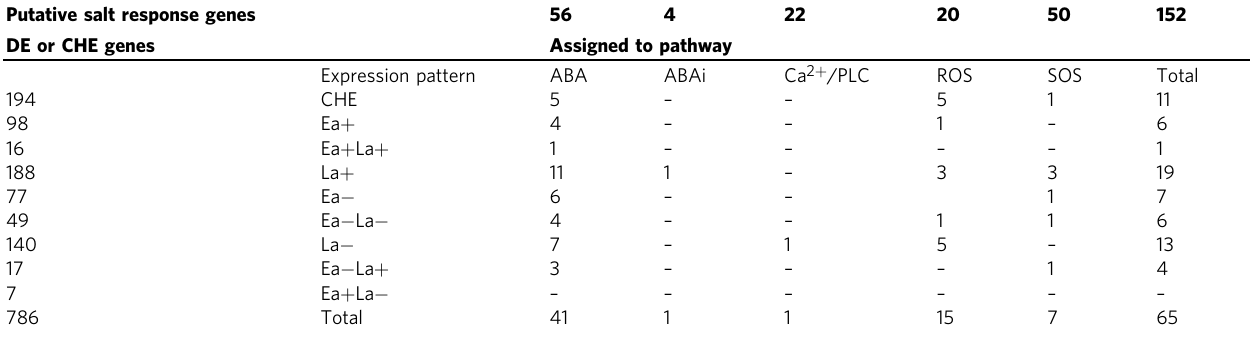
The fi rst column is devoted to the distribution of the eight genes classes with a signi fi cant pattern. In the second column, “ Ea ” refers to increased ( + ) or decreased ( − ) expression at 4h, “ La ” to variations of expression at 6 or 10 days. “ CHE ” stands for “ constitutively highly expressed. The fi rst row is devoted to the distribution of the 152 homologs of rice or Arabidopsis genes involved in salt resistance. The rest of the table represents the distribution of the 65 genes that are common to both